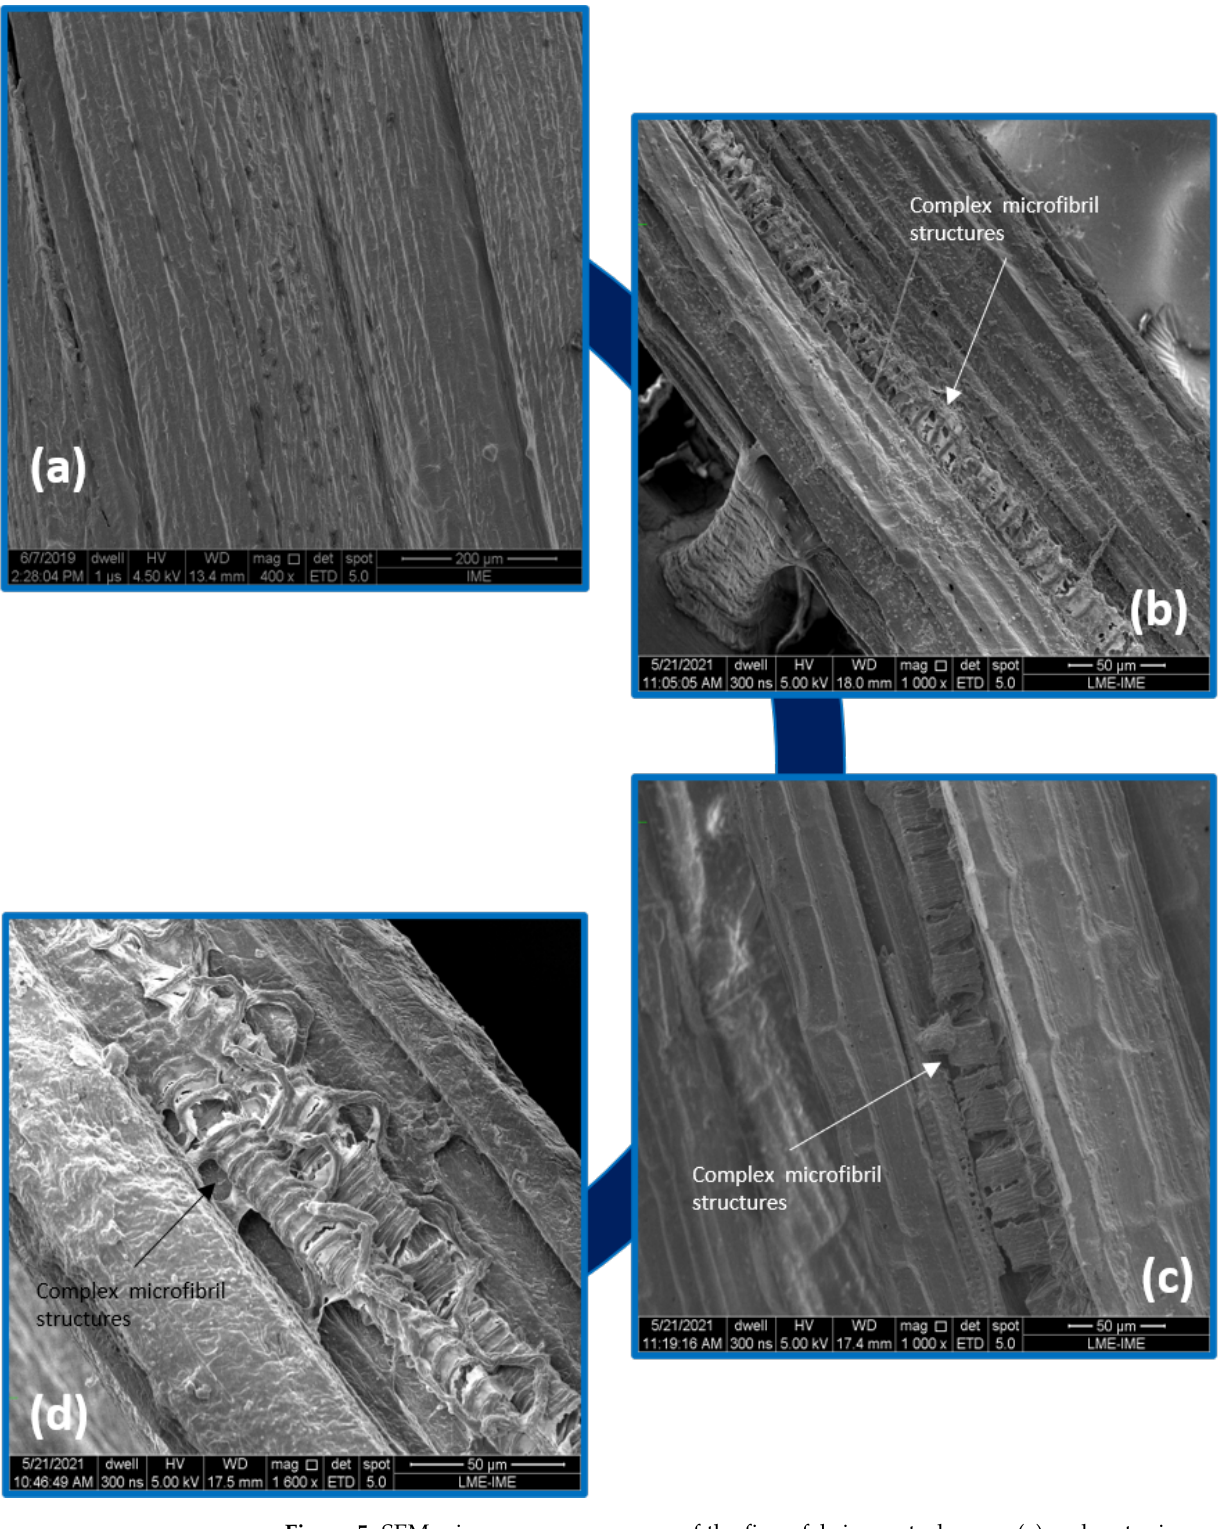
Figure 5. SEM microscopy appearance of the fique fabric: control group ( a ) and water immersion aged after 240 h ( b ), 720 h ( c ) and 1440 h ( d